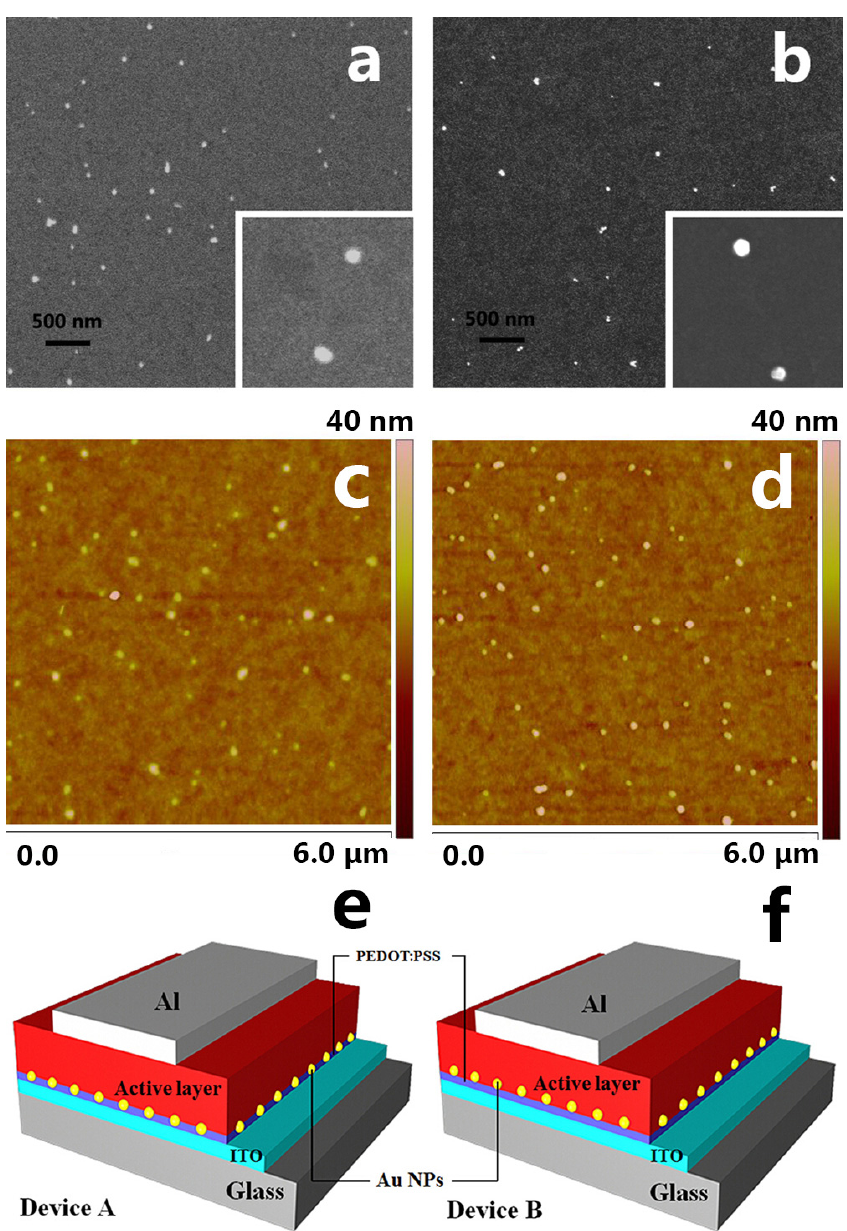
Figure 1. Scanning electron microscopy (SEM) images of gold nanoparticles (Au NPs) blend into poly(3,4-ethylenedioxythiophene) poly(styrenesulfonate) (PEDOT:PSS) film ( a ) and on the PEDOT:PSS film ( b ); atomic force microscope (AFM) images of Au NPs blend into PEDOT:PSS film ( c ) and on the PEDOT:PSS film ( d ); the structures of two plasmon-enhanced devices ( e , f